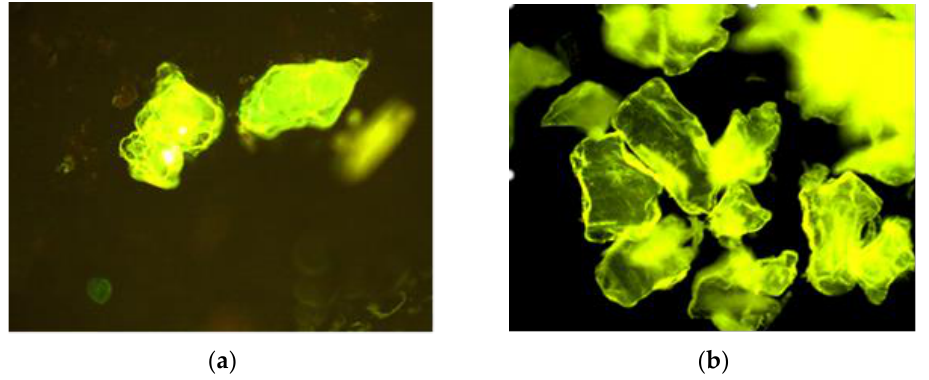
Figure 7. Fluorescent emissions (epifluorescence microscopy (×100)) of: ( a ) chitosan powder ex- tracted from capsules; ( b ) commercial chitosan powder.